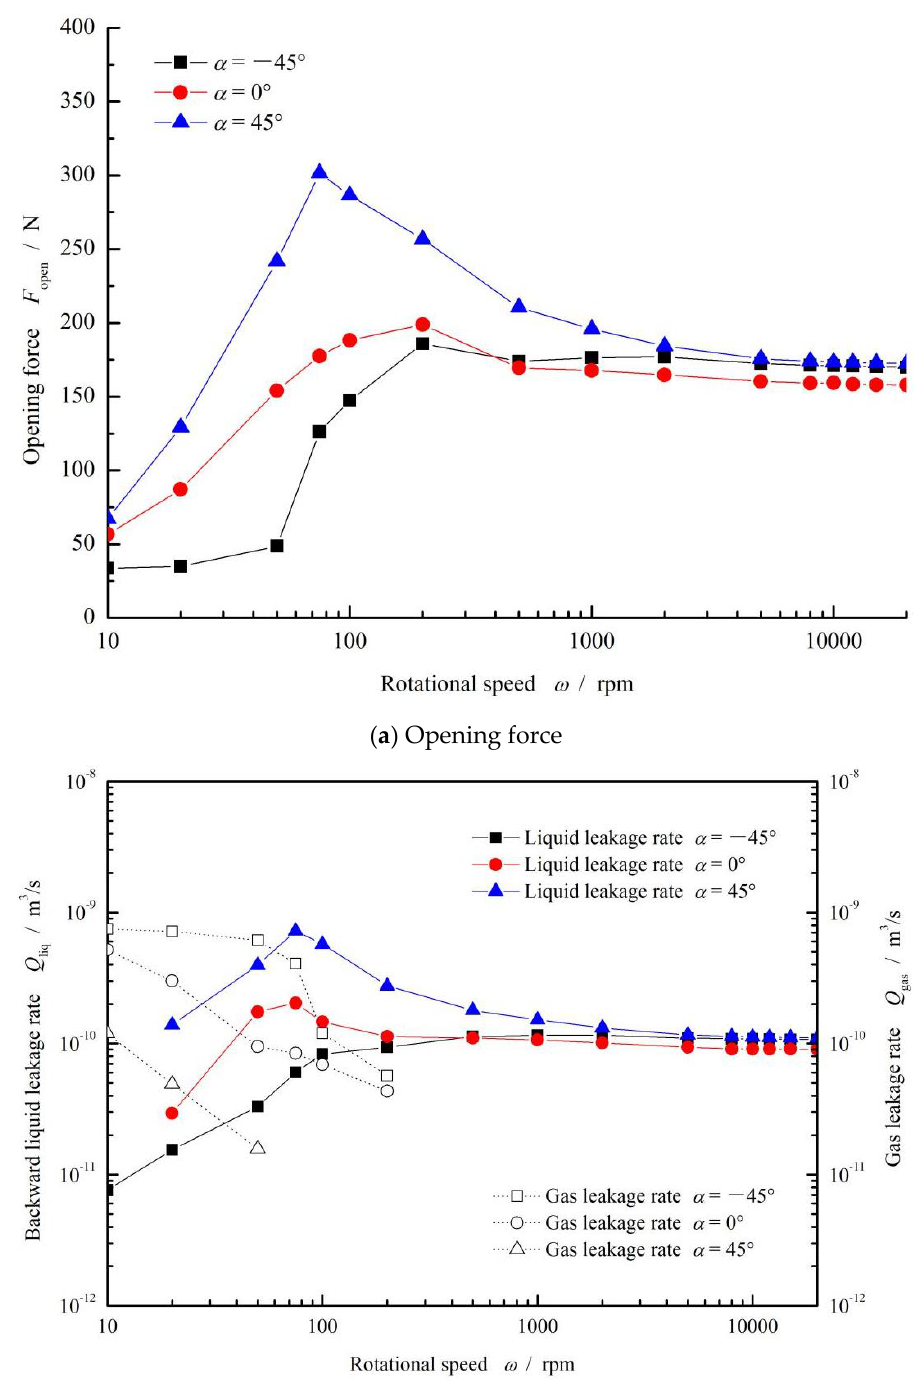
Figure 6. Effect of rotational speed on the opening force ( a ) and leakage rate ( b ). ( p o = 0.3 MPa, h 0 = 2 µ m, γ = 3.5 and N =